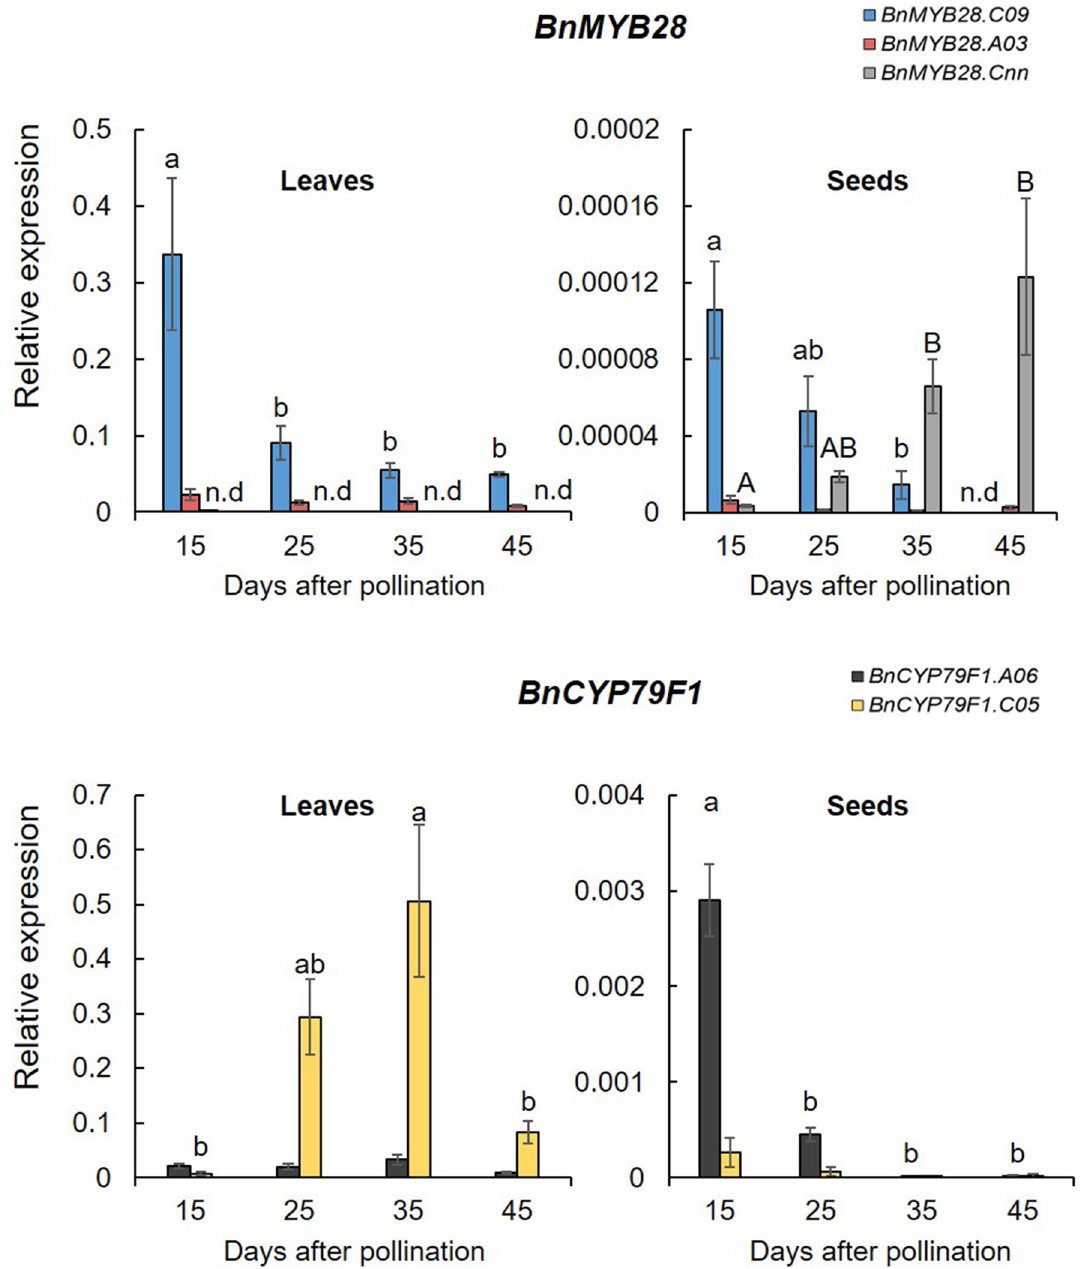
Figure 1. Relative expression of three BnMYB28 and two BnCYP79F1 paralogs in the winter-type oilseed rape Express617. Plants were grown in the greenhouse (20–25 °C and 16 h light) after vernalization (4 °C, 16 h light for 8 weeks). For each gene, leaves and seeds were sampled from five plants 15, 25, 35, and 45 days after pollination (five biological replicates). RT-qPCR was performed with three independent samples of each plant (three technical replicates) and the relative expression was calculated after normalization with two reference genes, BnACTIN and BnGAPDH . Error bars represent the standard error of the mean of five biological replicates, with three technical replicates each. Statistical significance was calculated with an ANOVA ( p < 0.05, linear model, grouping: Tukey test) using the R package ‘Agricolae’. Alphabets over bars represent statistical groups. n.d: not